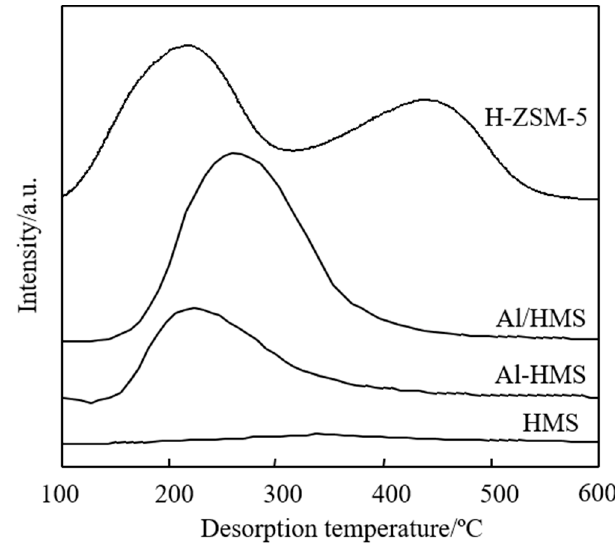
Figure 3. NH 3 -TPD profiles of various samples after calcining at 550 °C for 4 h.